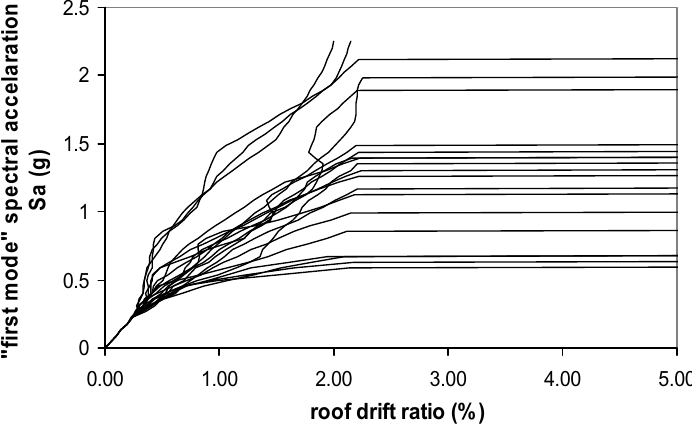
Fig. 4. IDA curves for the existing building for